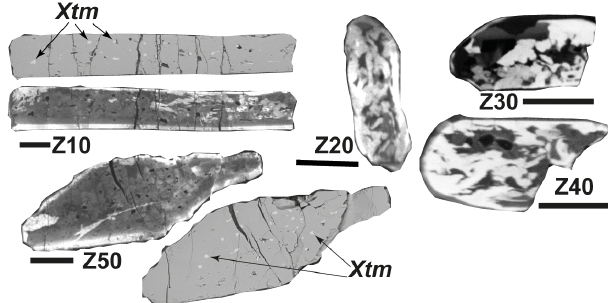
Figure 5. Cathodoluminescence images of representative zircon structures in garnet amphibolite interlayered with paragneiss and backscattered electron images of zircons Z10 and Z50, showing in- clusions of xenotime (Xtm). Scale bars are 50µm.